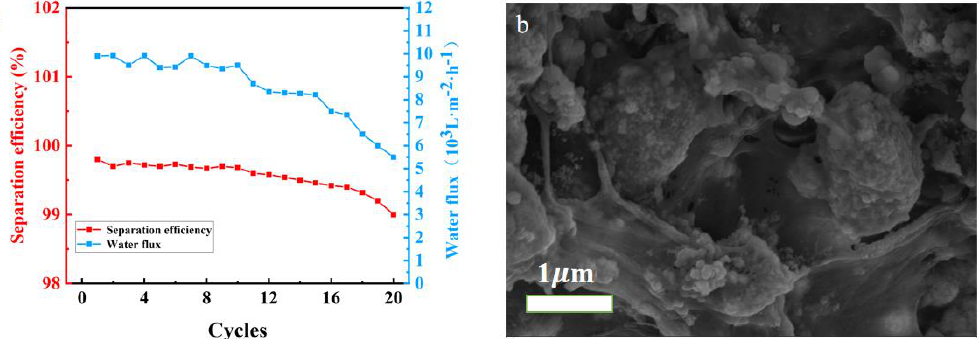
Figure 7. ( a ) Dynamic process of oil − water separation ( b ) Water flux and separation efficiency of six oil − water mixtures (A − F represent dichloroethane, petroleum ether, toluene, soybean oil, diesel, hexane and water mixtures, respectively).